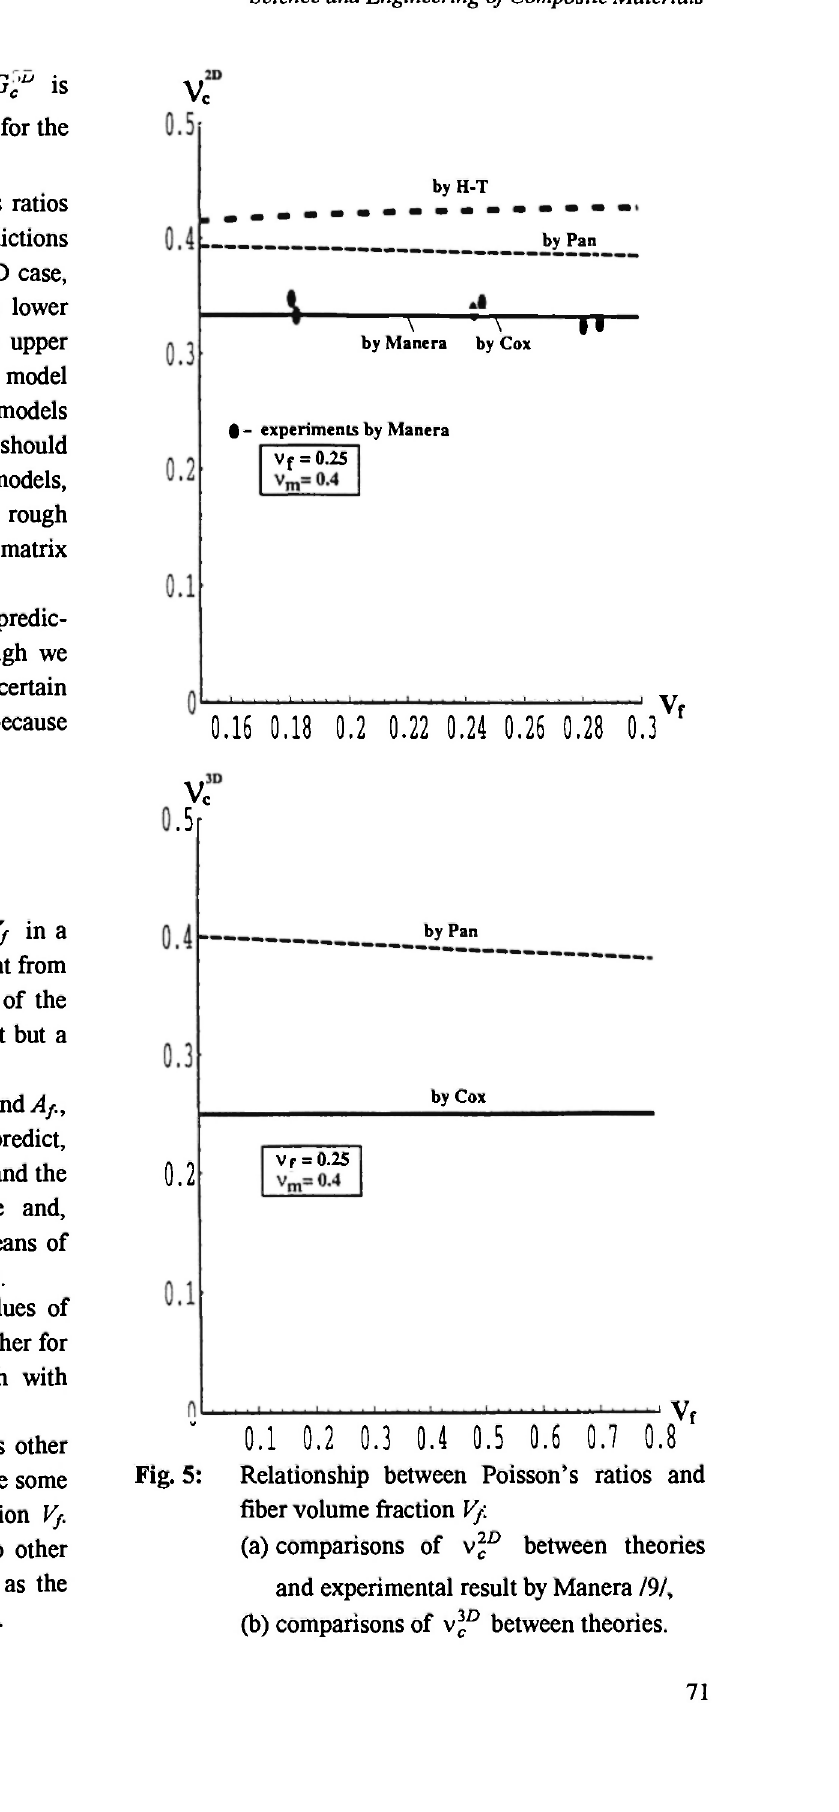
Fig. 5: Relationship between Poisson's ratios and fiber volume fraction Vf. (a) comparisons of v 2 c D between theories and experimental result by Manera 191, (b) comparisons of \ \ D between